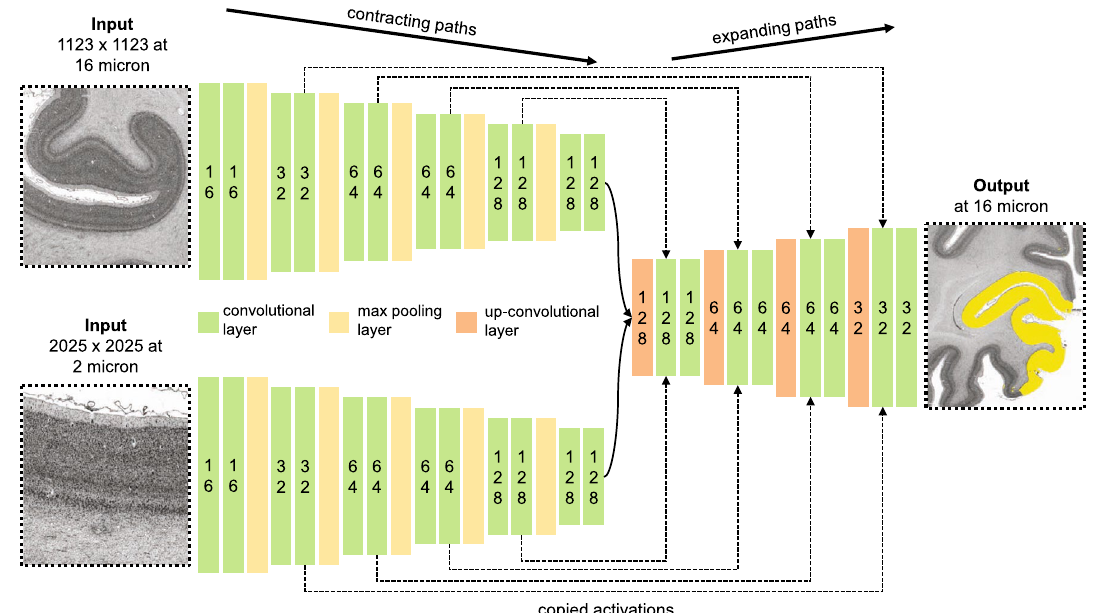
Figure 3. Scheme of the used CNN architecture inspired by the U-Net 34 . The blocks in the contracting branches consist of two convolutional layers and a pooling layer. The output of each convolution is parsed through a batch normalization and a rectified linear unit (ReLU). Each block in the expanding branch consists of an up-convolutional and two convolutional layers, each followed by a batch normalization and a ReLU. High resolution activations from the contracting path are combined with the outputs of the up-convolutional layers in the expanding branch. Numbers in boxes indicate the number of network units in a respective layer. All branches consist of 864 network units leading to a total of 2592 units per